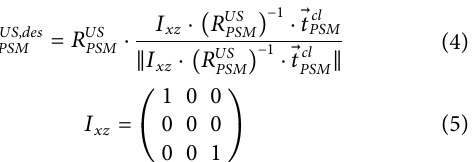
Frontiers in Robotics and AI |